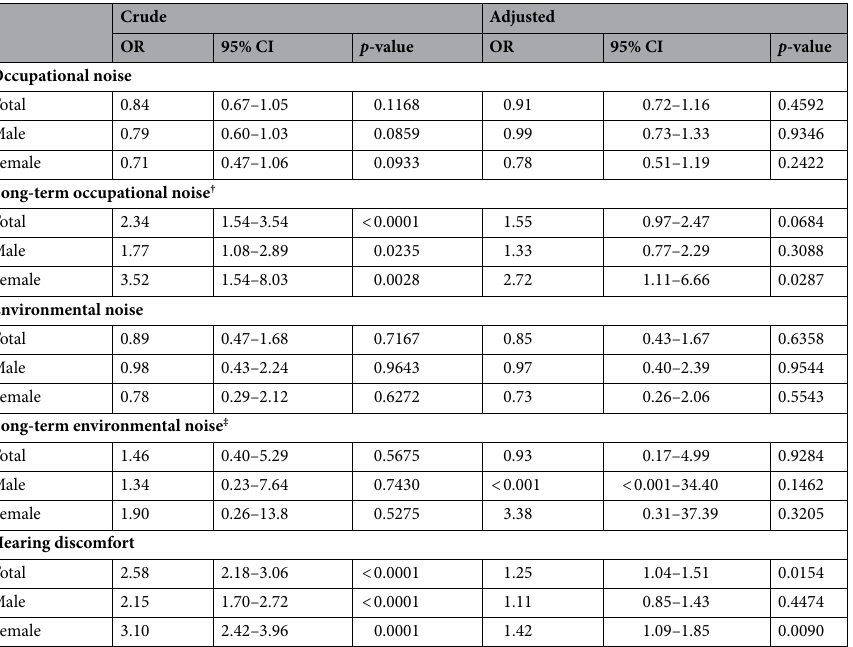
Table 2. Results of the logistic regression analysis for noise exposure and CKD. Adjusted for age, sex, educational state, household income, urbanity, hypertension, diabetes, dyslipidemia, body mass index, smoking, high-risk alcohol consumption, and aerobic physical activity. The cut-off value of long-term exposure is the third quartile of the noise exposure period. OR odds ratio, CI confidence interval, CKD chronic kidney disease. † Only for participants with occupational noise exposure ( n = 2915). “Long-term” refers to occupational noise exposure for ≥ 240 months. ‡ Only for participants with environmental noise exposure ( n = 303). “Long-term” refers to environmental noise exposure for ≥ 300 min per